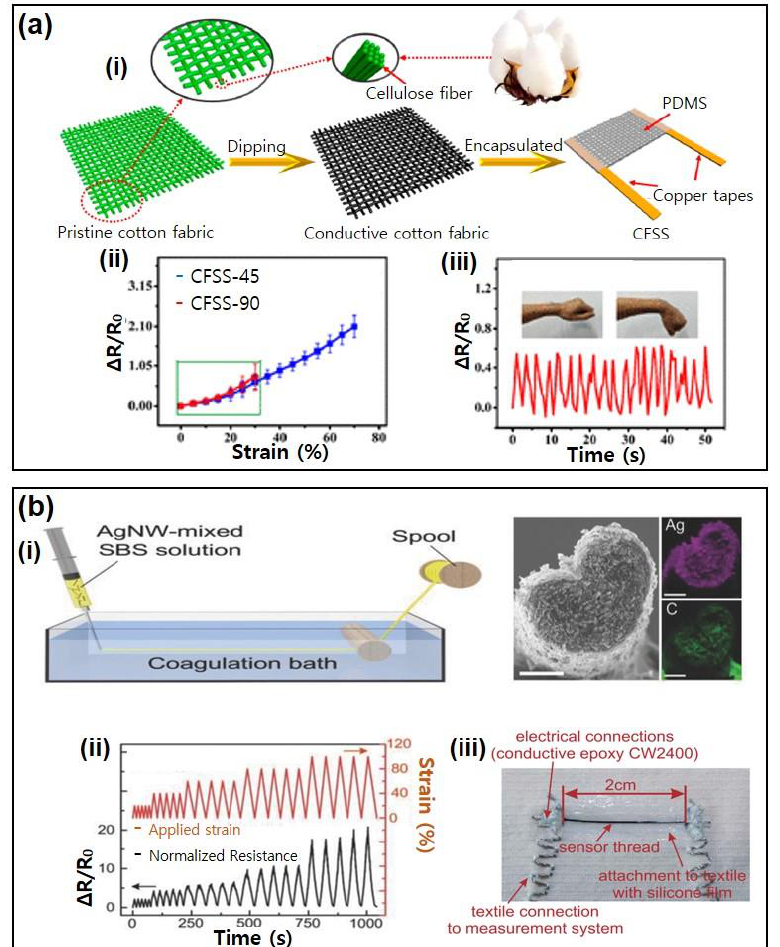
Figure 1. Fiber-based resistive tactile sensors. ( a ) (i) Natural fabrics can be made into tactile sensors through dip-coating. Pristine cotton fabric was dipped into a solution of multilayer graphene. (ii) The behavior of this sensor’s resistance in response to strain. (iii) The cotton fabric-based tactile sensor was attached to a human wrist to monitor wrist bending. Reproduced with permission from [30], Copyright (2020), American Chemical Society. ( b ) (i) Conductive composite fibers can be fabricated through spinning methods. SBS-AgNW mixture was wet-spun into a conductive composite fiber (left). Cross-sectional image of SBS-AgNW fiber (right). (ii) The behavior of SBS-AgNW fiber’s resistance in response to strain. Reproduced with permission from [63], Copyright (2015), Wiley. (iii) A fibrous sensor was attached to a textile using a silicone film. Reproduced with permission from [41], Copyright (2008), MDPI.